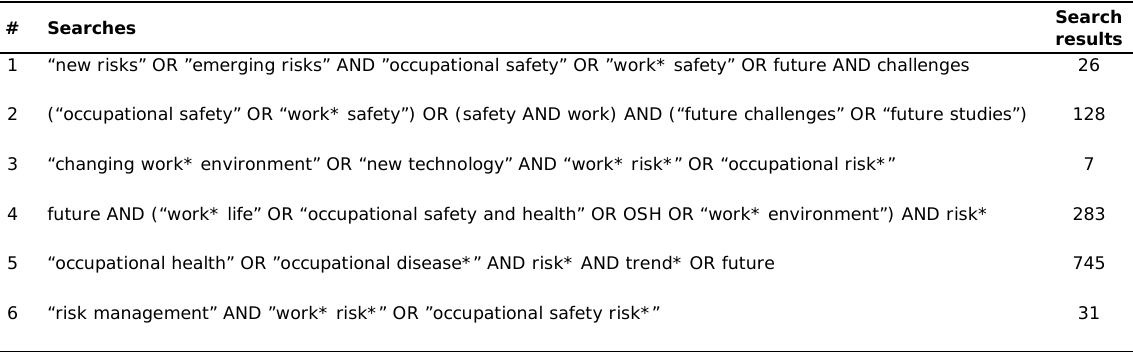
Table 1. Searches and search